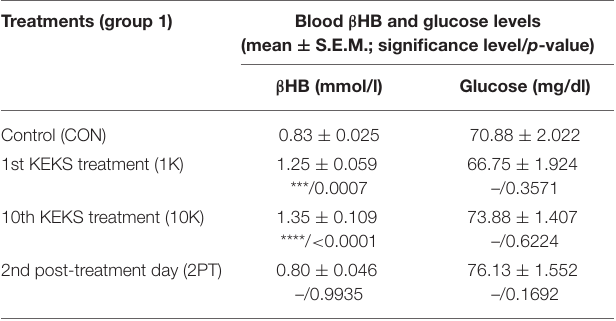
TABLE 5 | Effect of IP indomethacin and lipopolysaccharide alone, as well as their combined administration on SWD number ( Figure 3 , group 2–4). Treatments (Figure 3; groups 2–4)